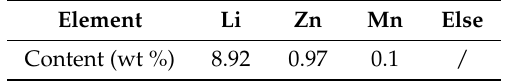
Table 1. The LZ91 alloy composition.